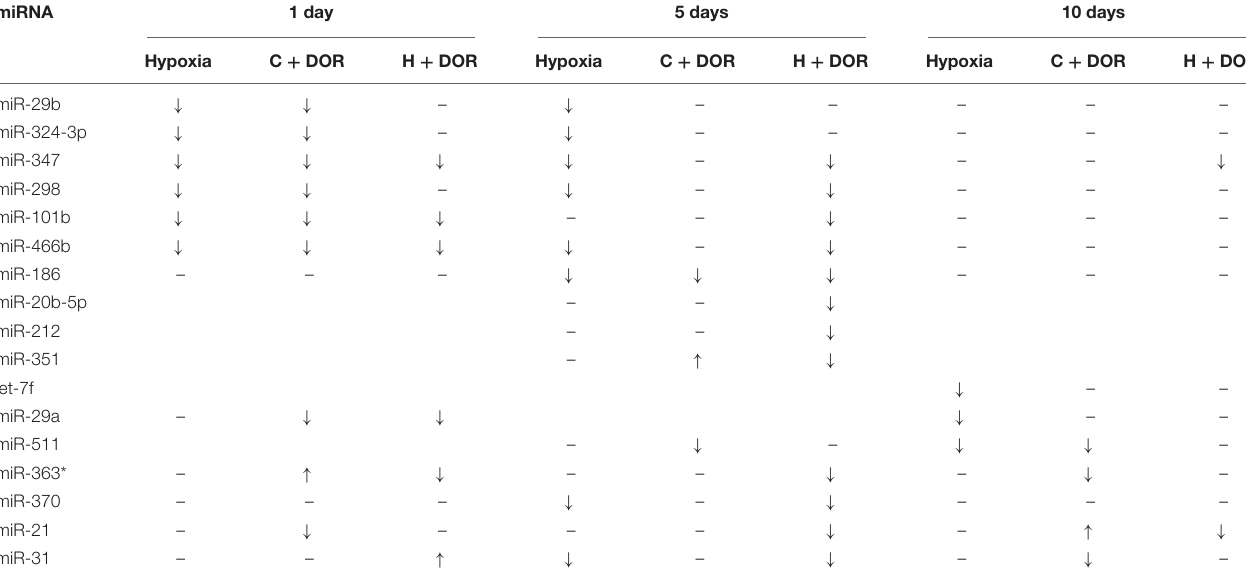
TABLE 6 | Effects of DOR activation on brain miRNAs in prolonged hypoxia. miRNA